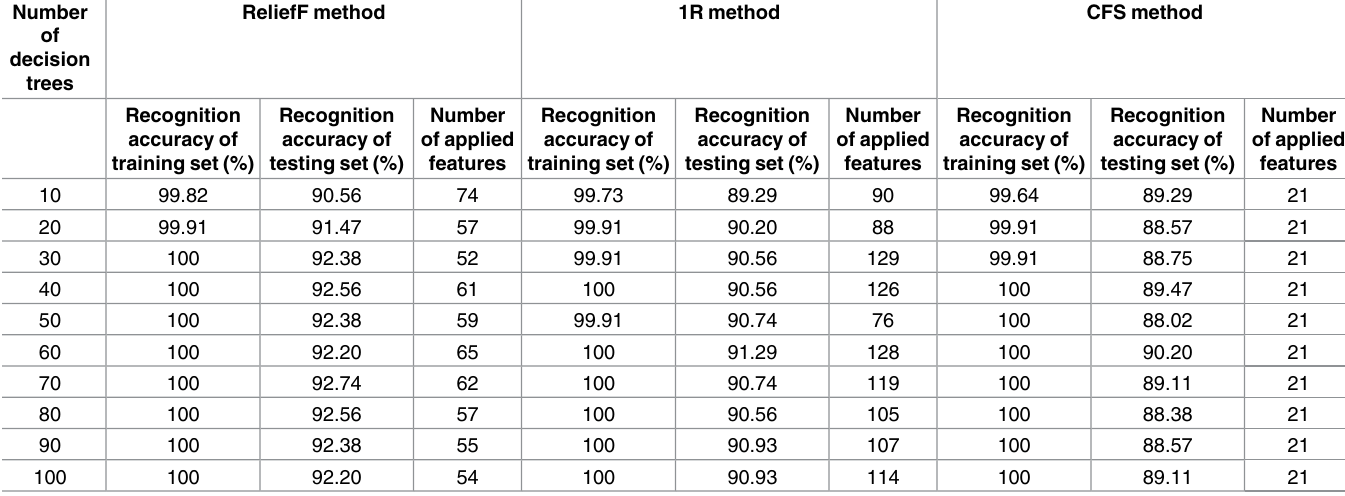
Note: For each number of decision trees, only the best random forest model for the recognition of the four alfalfa leaf diseases is shown when the features were selected using the ReliefF method or 1R method.